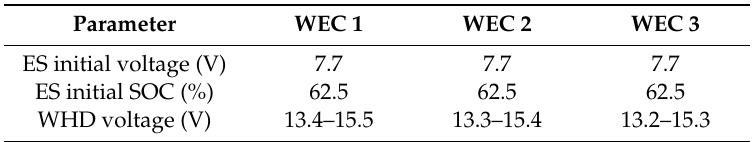
Table 3. Initial parameters of Test 3.